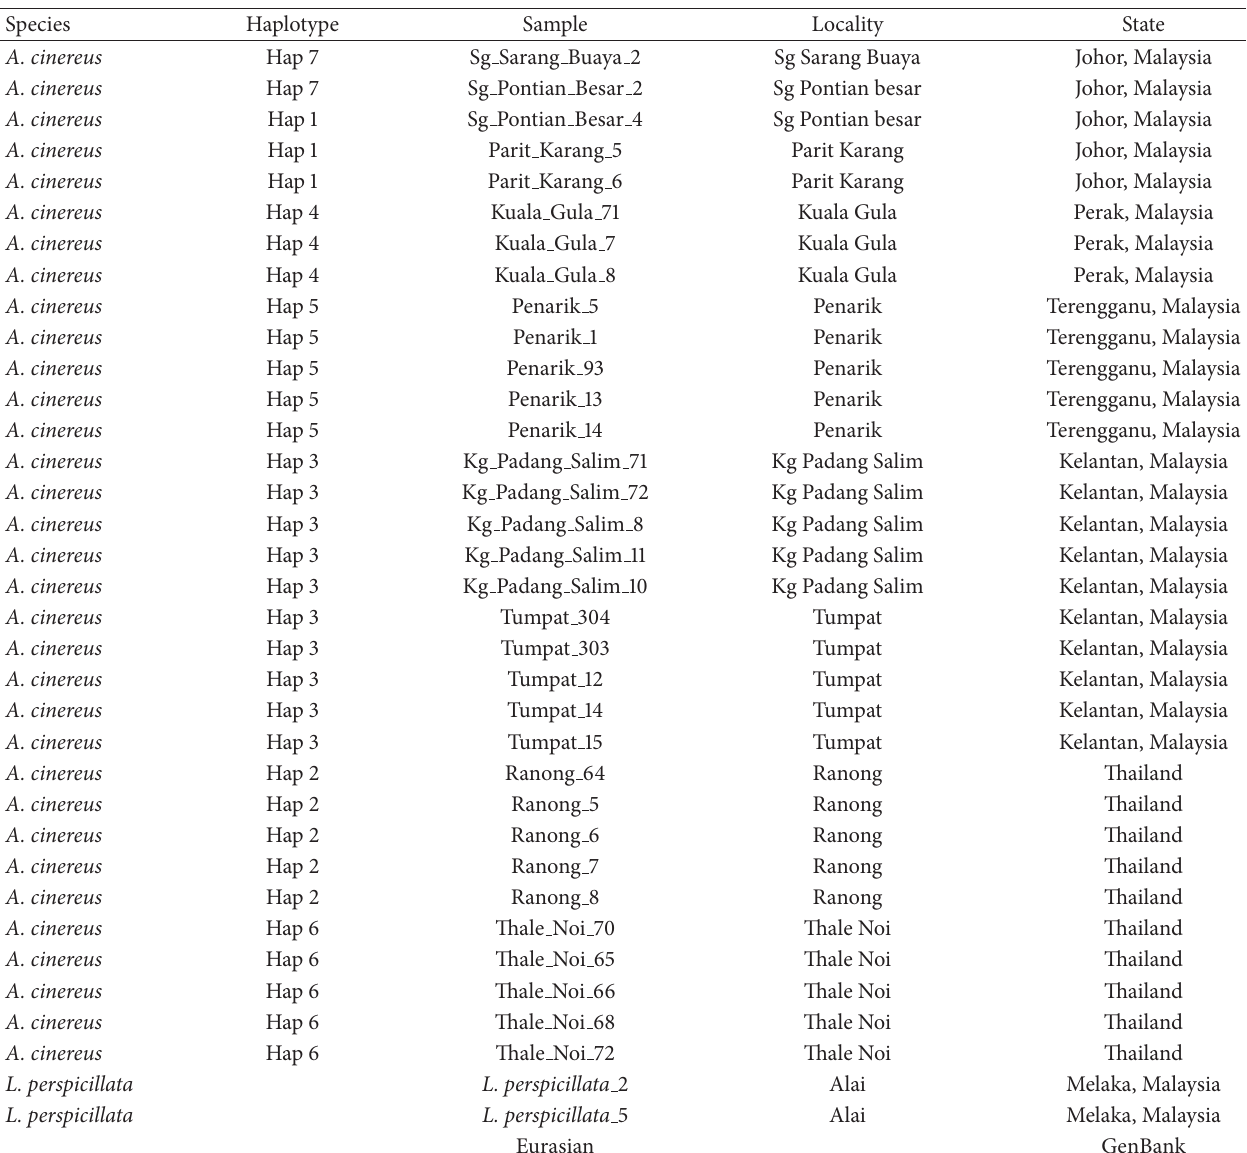
Table 1: List of